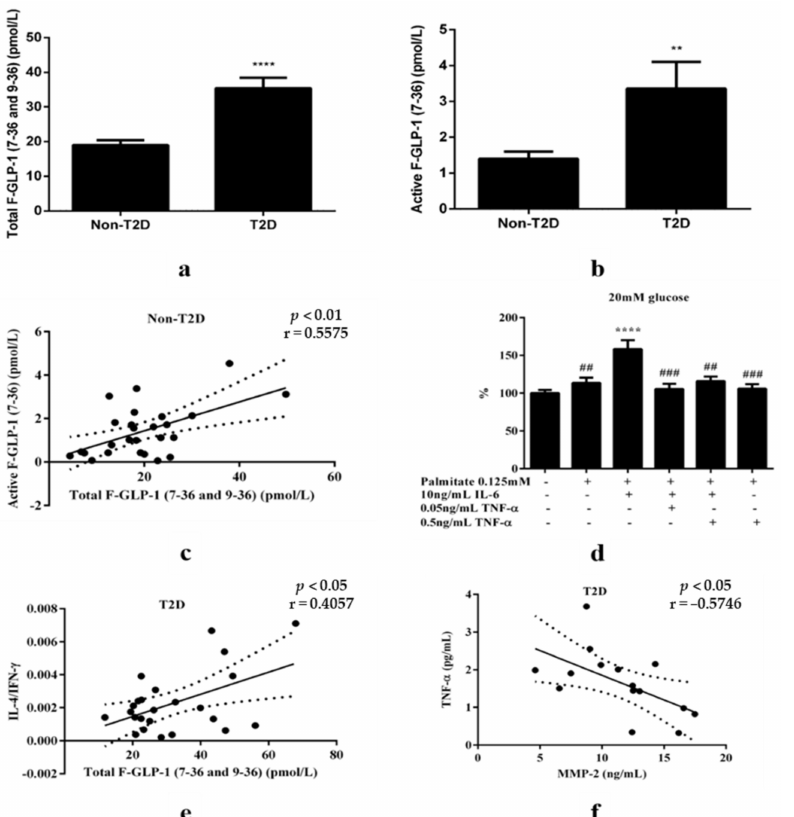
Figure 3. Increased F-GLP-1 is associated with a Th2 inflammatory profile in T2D patients. ( a ) Total F-GLP-1 levels (including GLP-1 7-36 amide and 7-37 [active form] and the metabolite GLP-1 9-36) were higher in T2D patients, as compared to controls, p < 0.0001 ( n = 63 for control, n = 37 for T2D). ( b ) Active F-GLP-1 levels were higher in T2D patients, p < 0.01 ( n = 28 for non-T2D, n = 8 for T2D). ( c ) A positive correlation was observed between total and active GLP-1 for non-T2D ( n = 26). ( d ) In the presence of a simulated diabetic milieu (0.125 mM palmitate and 20 mM glucose), IL-6 stimulated GLP-1 secretion is abolished by TNF- α . + Presence of the indicated treatment − absence of indicated treatment. ( e ) A positive correlation between IL-4/IFN- γ ratio and F-GLP-1 levels ( n = 25) was detected in T2D patients. ( f ) A negative association with TNF- α was observed in the T2D group. Black dots represent analyzed levels for individual samples. Comparisons between groups were performed with an unpaired t -test or one-way ANOVA when comparing more than two groups. Significant correlations were assessed with the Pearson correlation coefficient, ** p < 0.01; **** p < 0.0001. For the in vitro experiment, **** p < 0.0001 compared with palmitate and glucose, ## p < 0.01, ### p < 0.001 compared with IL-6 in the presence of palmitate and